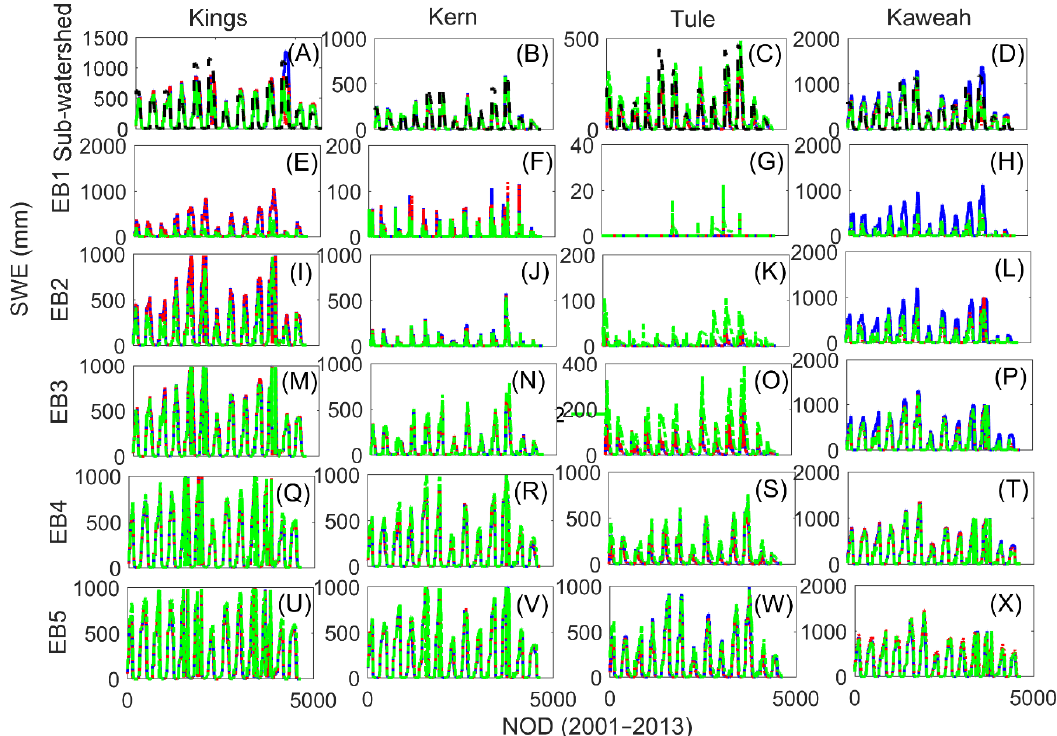
Figure 5. SWE calibration and validation results for the three calibration scenarios (S1–S3). ( A ) The distribution of NSEs as box-whisker plots for the predicted SWE in snow-calibrated sub-watersheds (locations are shown in ( C )) before and after the snow calibrations for S3. A1–A4 are the Kings, Kern, Tule, and Kaweah watersheds, respectively. BC, AC, and V refer to Before SWE Calibration, After SWE calibration, and Validation, respectively. ( B ) The averaged NSE values for the validation period (2008–2013) for the three scenarios. B1–B4 are the Kings, Kern, Tule, and Kaweah watersheds, respectively. ( C ) The snow-calibrated sub-watersheds (blue), poor-performing sub-watersheds (red), and one typical snow sub-watershed for each watershed (used in Figure 6).